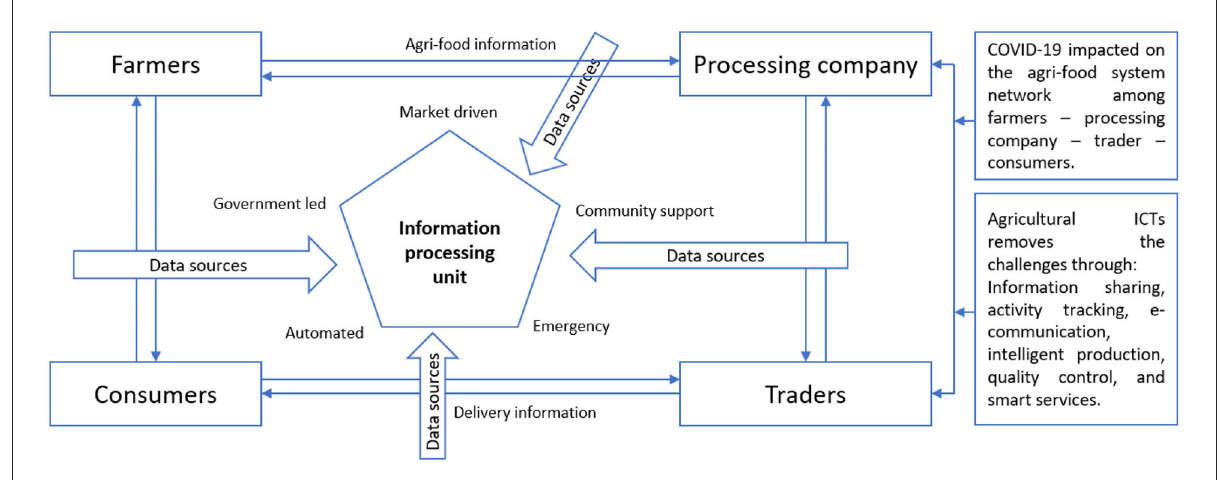
FIGURE3 ICT-enabled agriculture information service system for agri-food